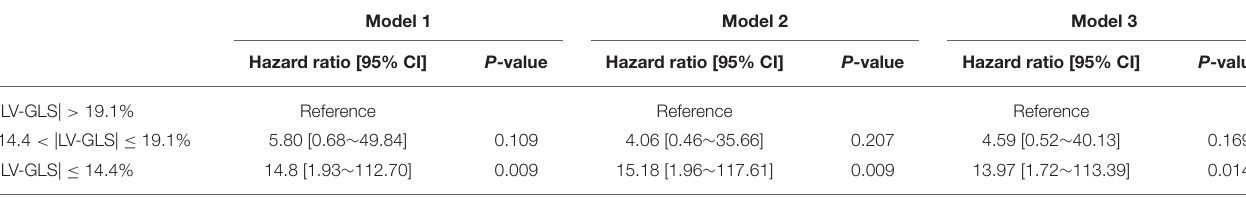
TABLE 4 | Cox regression analysis for CV outcomes.